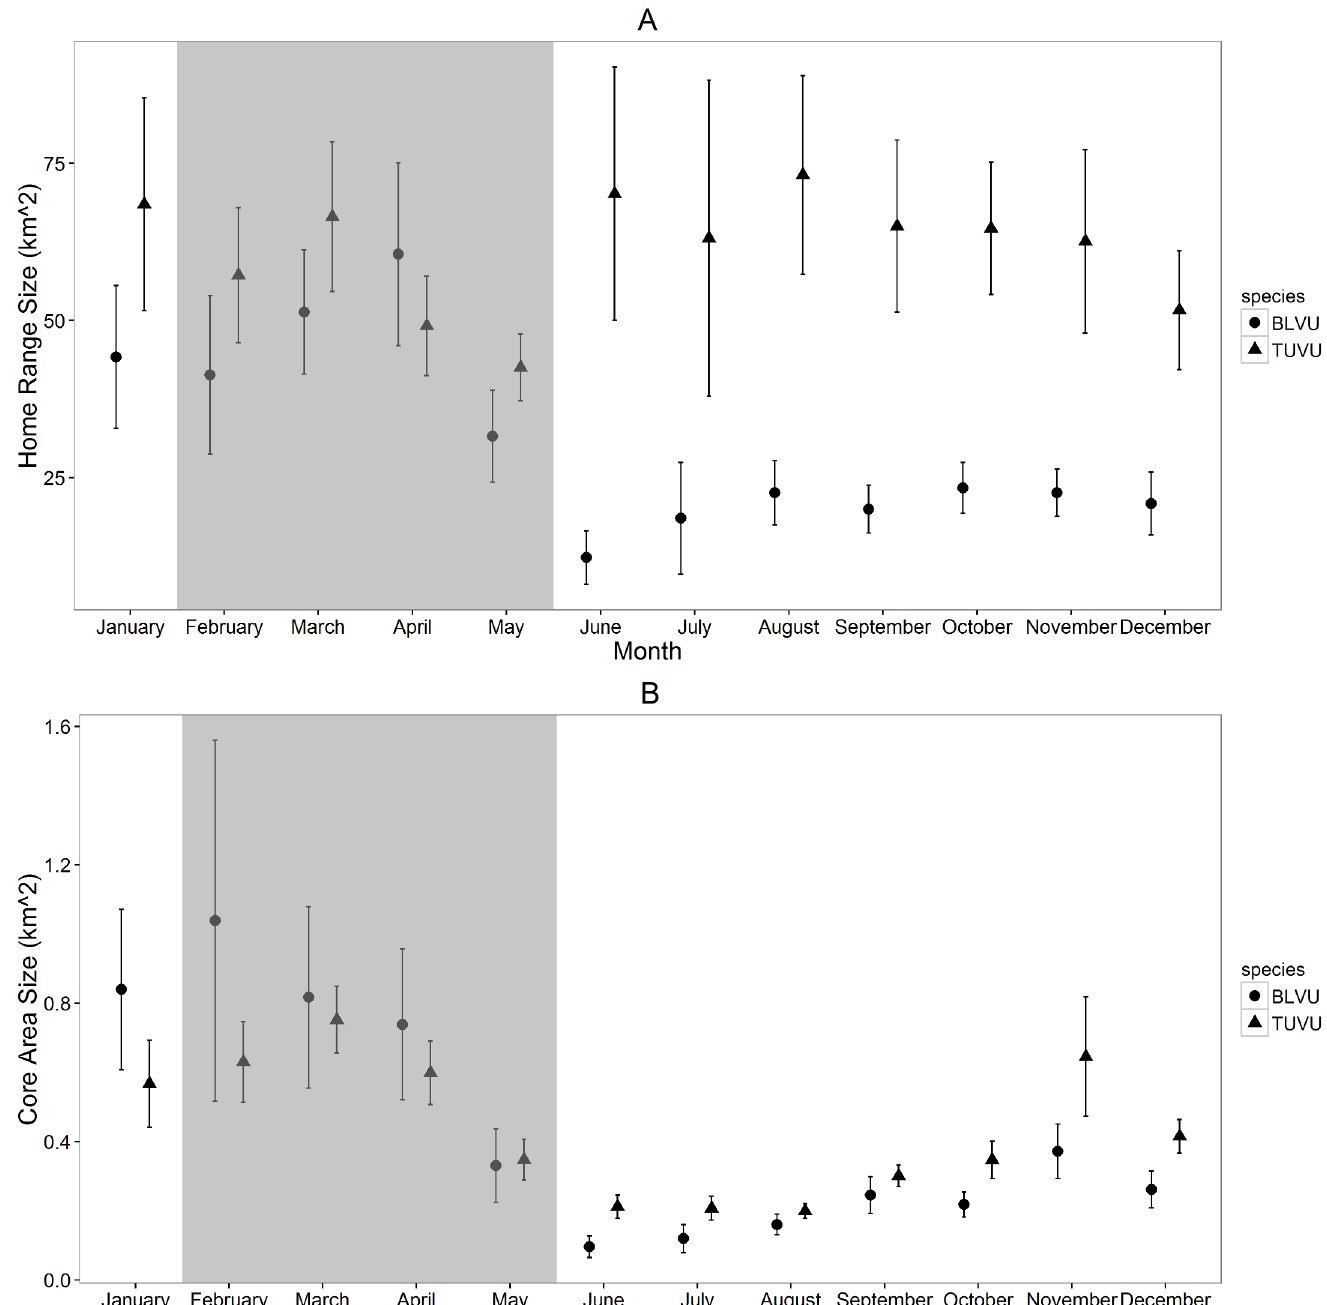
Fig 1. Mean ( ± SE) monthly (A) 95% home range and (B) 50% core area sizes (km 2 ) for 9 black vultures (BLVU; total locations = 804,470; mean locations/month = 8,429; range = 895–14,391) and 9 turkey vultures (TUVU; total locations = 1,372,194; mean locations/month = 9,026; range = 531–16,566)calculated from GPS locations collected September1, 2013 –August 31, 2015. Shadedregionhighlightsmonths within the